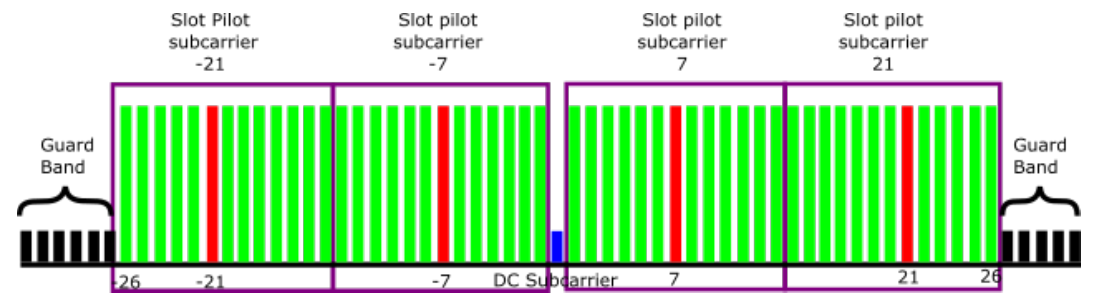
Figure 6. Subcarrier distribution